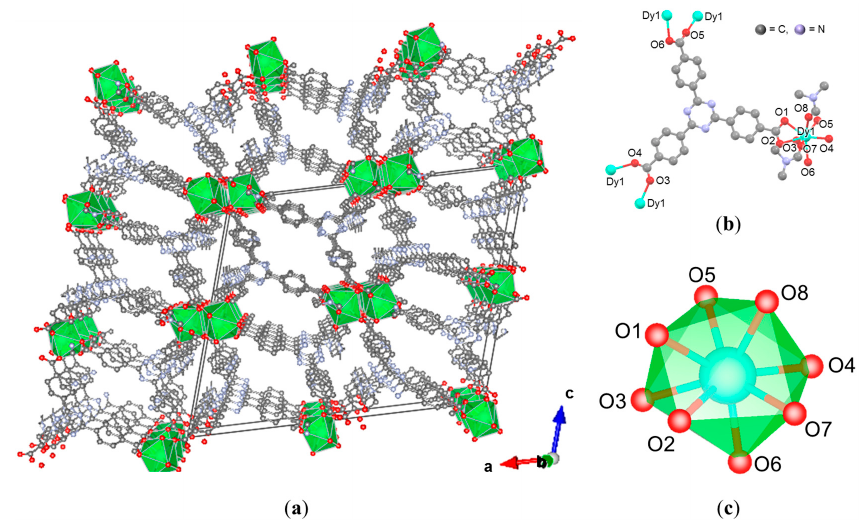
Figure 1. Drawings of ( a ) the crystal structures of lanthanoid metal-organic frameworks (Ln-MOFs) 1 and 2 ; and ( b ) the asymmetric unit of 1 . Hydrogen atoms and crystal solvents are omitted for clarity; ( c ) Distorted square antiprism coordination polyhedron of the Dy(III) ions in 1 .